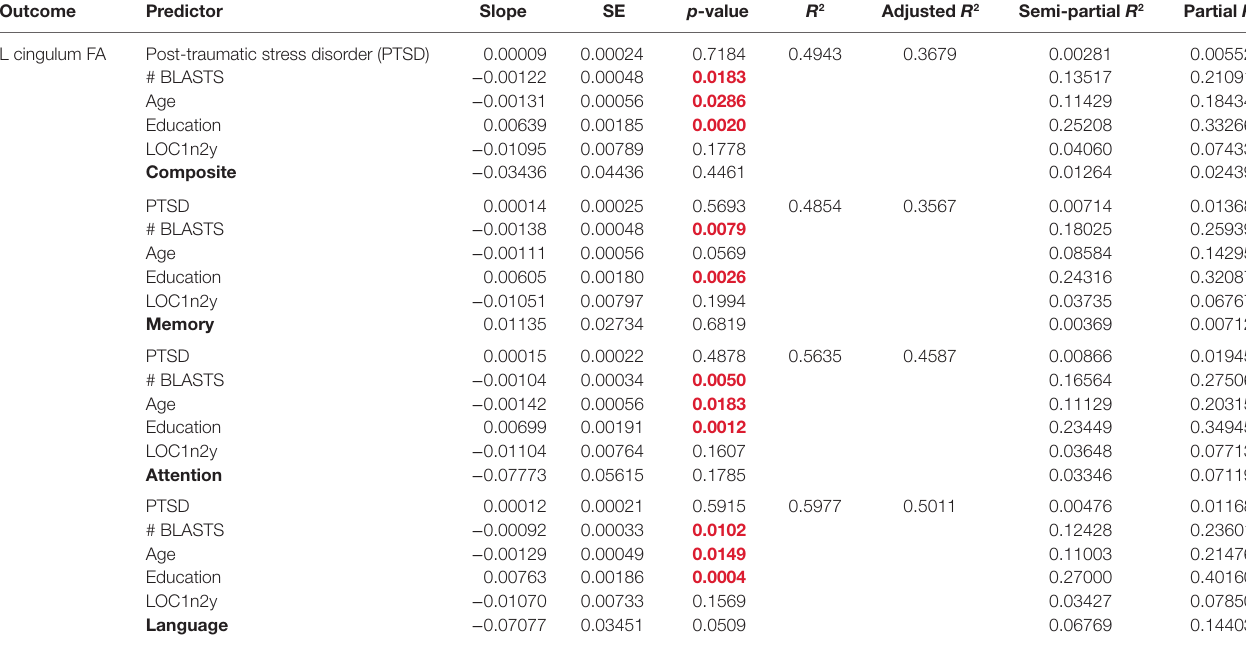
TaBle 8 | Predicting fractional anisotropy in the left